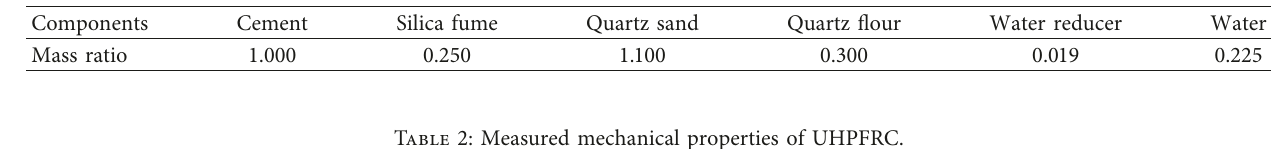
Table 1: UHPFRC mix